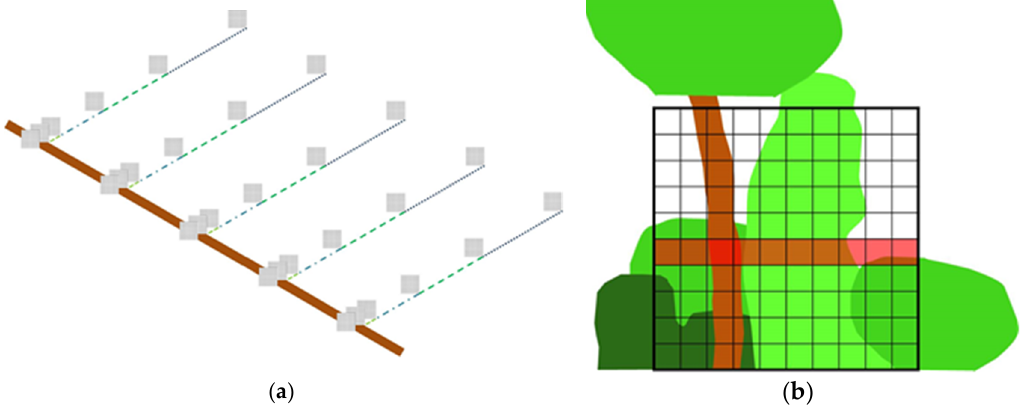
Figure 2. Arrangement of trail (brown) transects and quadrats for each sampling event at each sampling location ( a ) and measurement of the understory structure with the highest row shaded red ( b ).